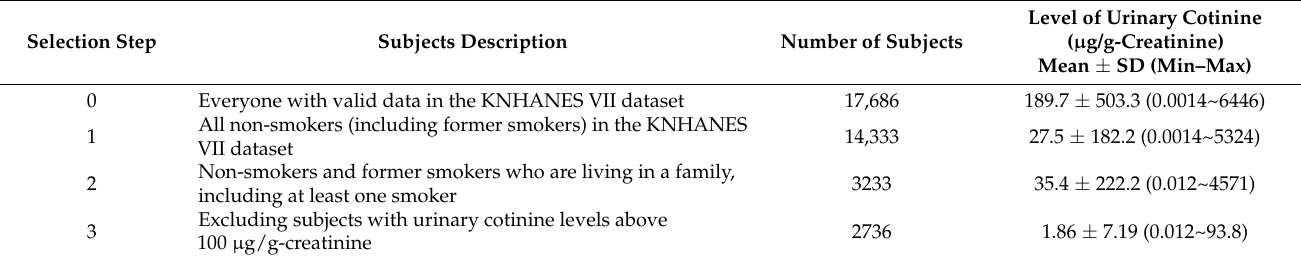
Table 1. Subject selection process from the KNHANES VII